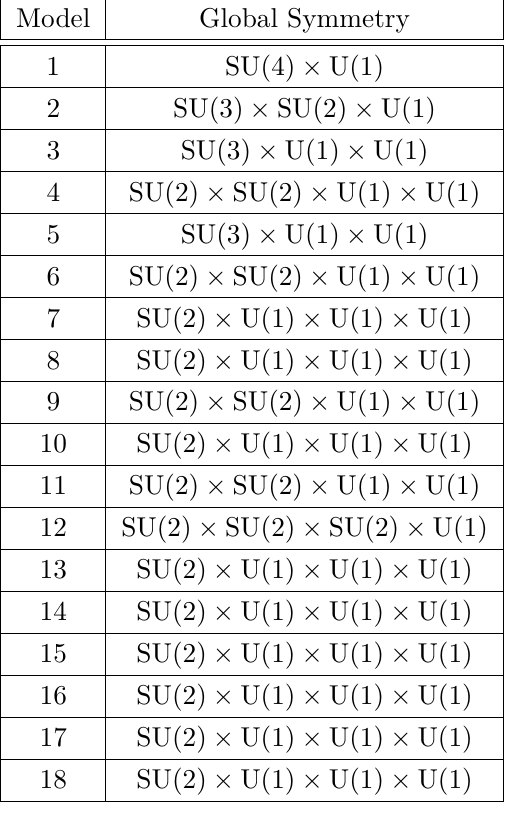
Table 5 . The global symmetries for the 18 models that can be obtained from the isometries of the toric Calabi-Yau